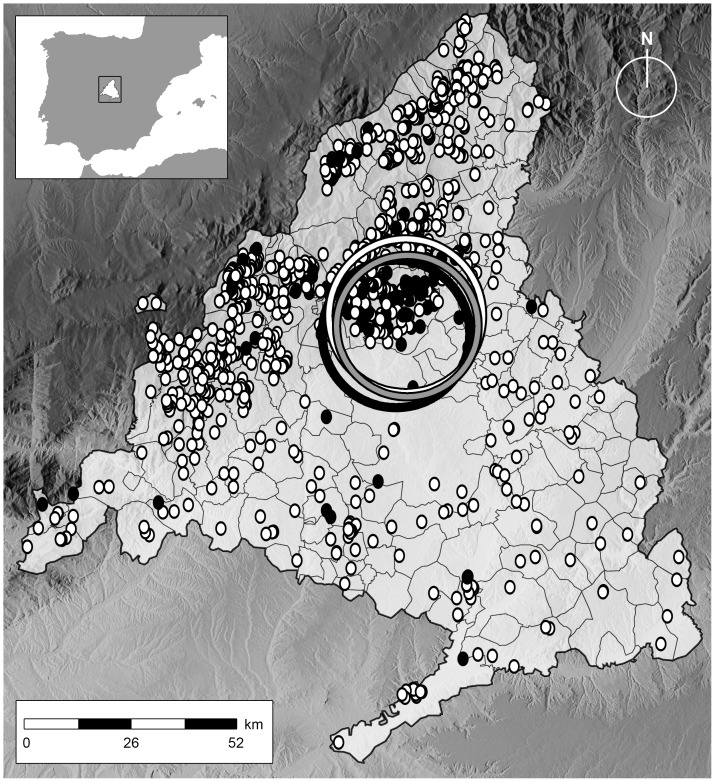
Location of cattle herds tested in the bTB eradication program during 2010–2012 in the ACM.Black dots indicate herds that were positive at some stage in 2010–2012, and white dots indicate herds consistently negative during the three years. Circles indicate clusters of high risk identified in 2010, 2011 and 2012.